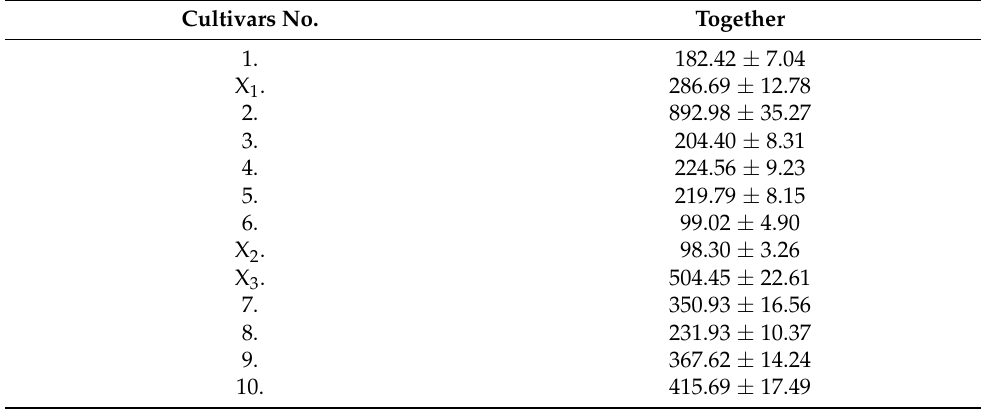
Table 4. The total contents of phenolic acids, flavonoids and salicylate compounds in young stems of selected willow species, varieties and cultivars, spring of 2017 ( µ g/g DM). The numbers of cultivars as in Table 1. Cultivars No.